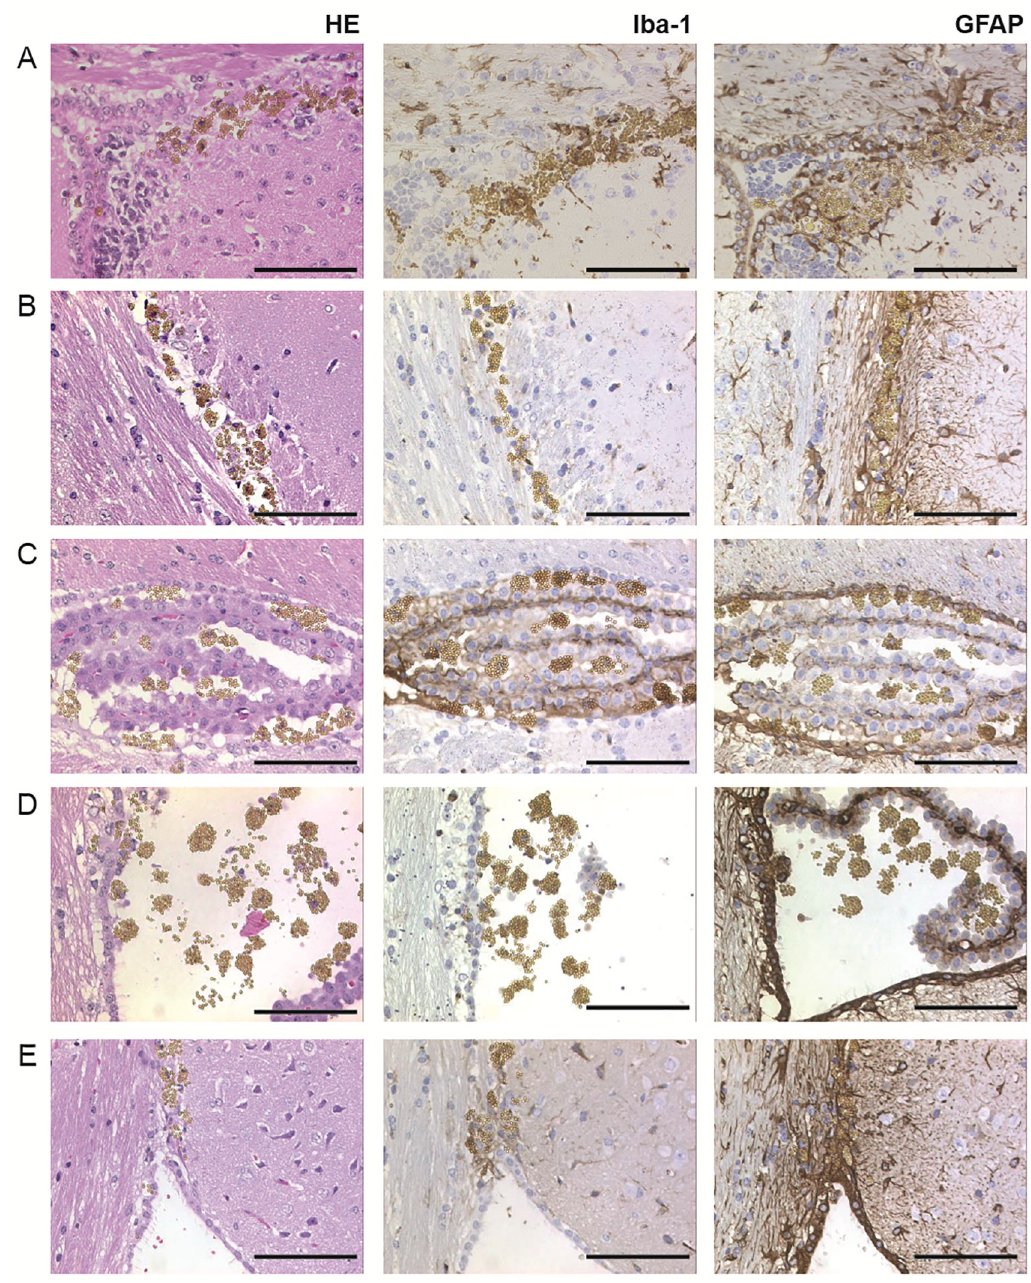
Fig 1. Histopathological analysis of tissue reactions to intracerebral bead inoculation. Tg a 20 mice were inoculated with PSR1 beads that had been exposed to wt CD1 brain homogenates. Vacuolation by hematoxylin-eosin staining (HE), astrocytic gliosis was documented by an antibody directed against the glial fibrillary acidic protein (GFAP), and microgliosis was assessed with the activated microglial marker (Iba-1). (A) Brain sections of a tg a 20 mice analysed at 8 dpi showed bead accumulation near the injection site. (B) Brain sections analyzed at 31 dpi showed accumulation of the beads adjacent to the corpus callosum, (C) choroid plexus and (D) lateral ventricle, and in the area between corpus callosum and the septofimbrial nucleus (E). (Scale bars: 100 μ